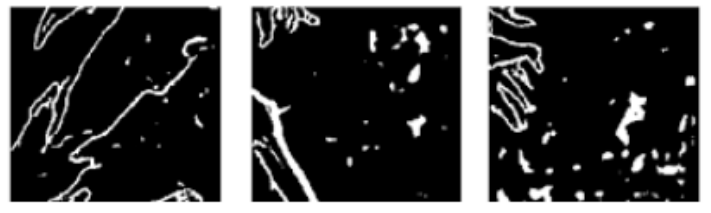
Figure 14. Some segmentation results with white spot noise.